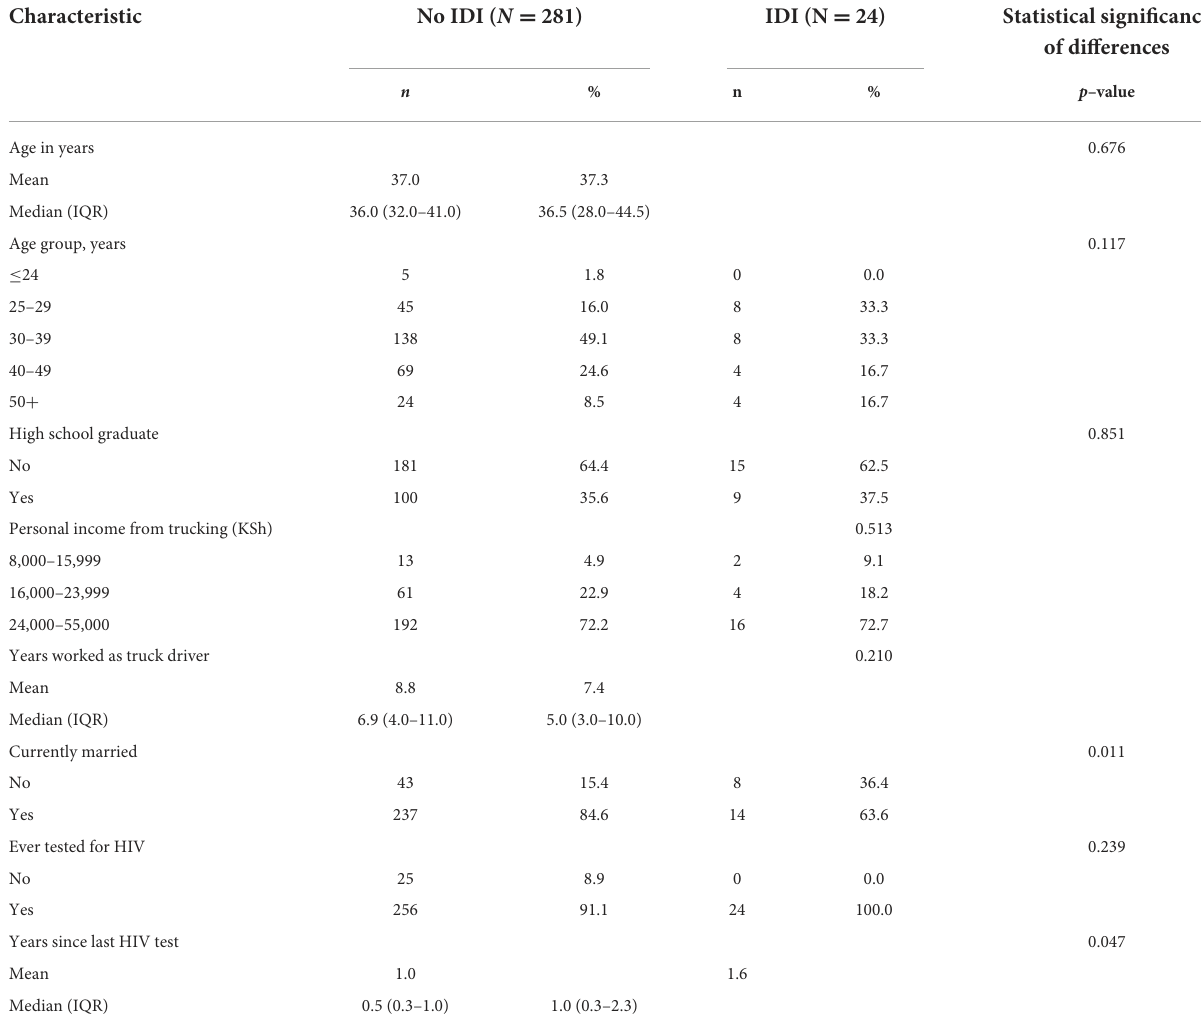
TABLE 1 Descriptive characteristics of participants in the HIVST RCT and of those choosing not to test, Nakuru County, Kenya, 2015.